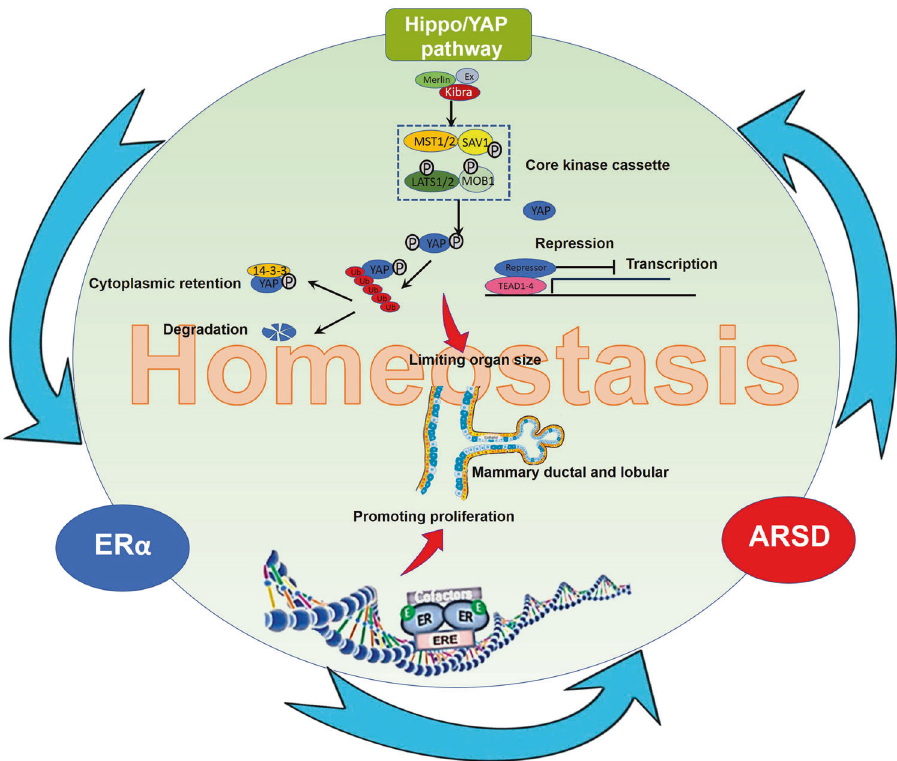
Fig. 7 There might exist a constrained work fl ow model among ER α , ARSD, and Hippo/YAP pathway. ARSD, as a molecule brake on ER α signaling pathway, restricts ER α in an uncontrolled active state and avoids the overgrowth caused by ER α through activating Hippo/YAP pathway in order to reach homeostasis in breast luminal epithelial